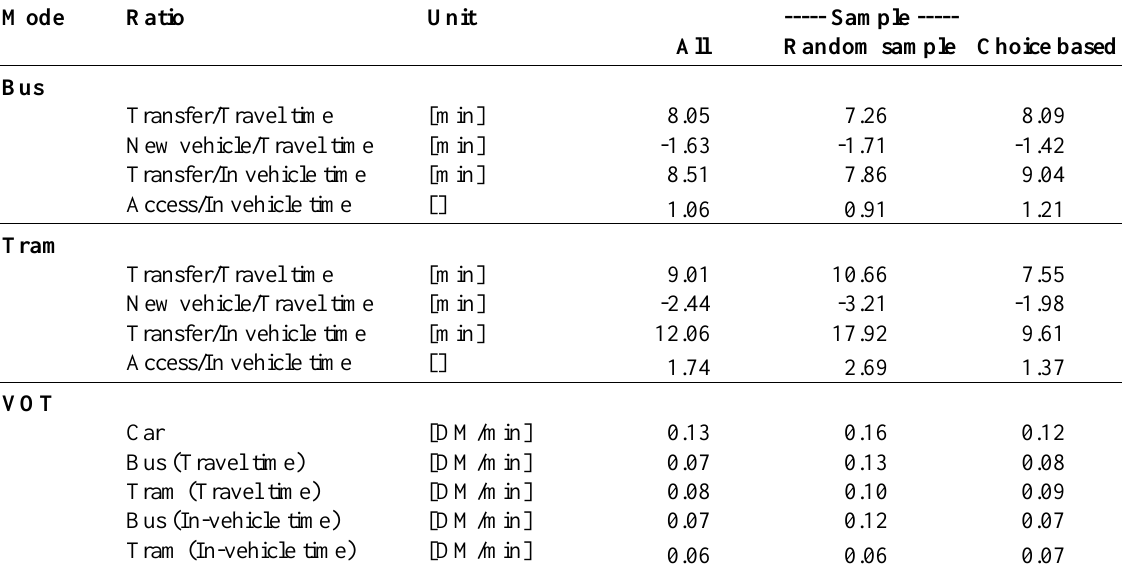
Table 8. Joint RP and SP estimation: Derived ratios